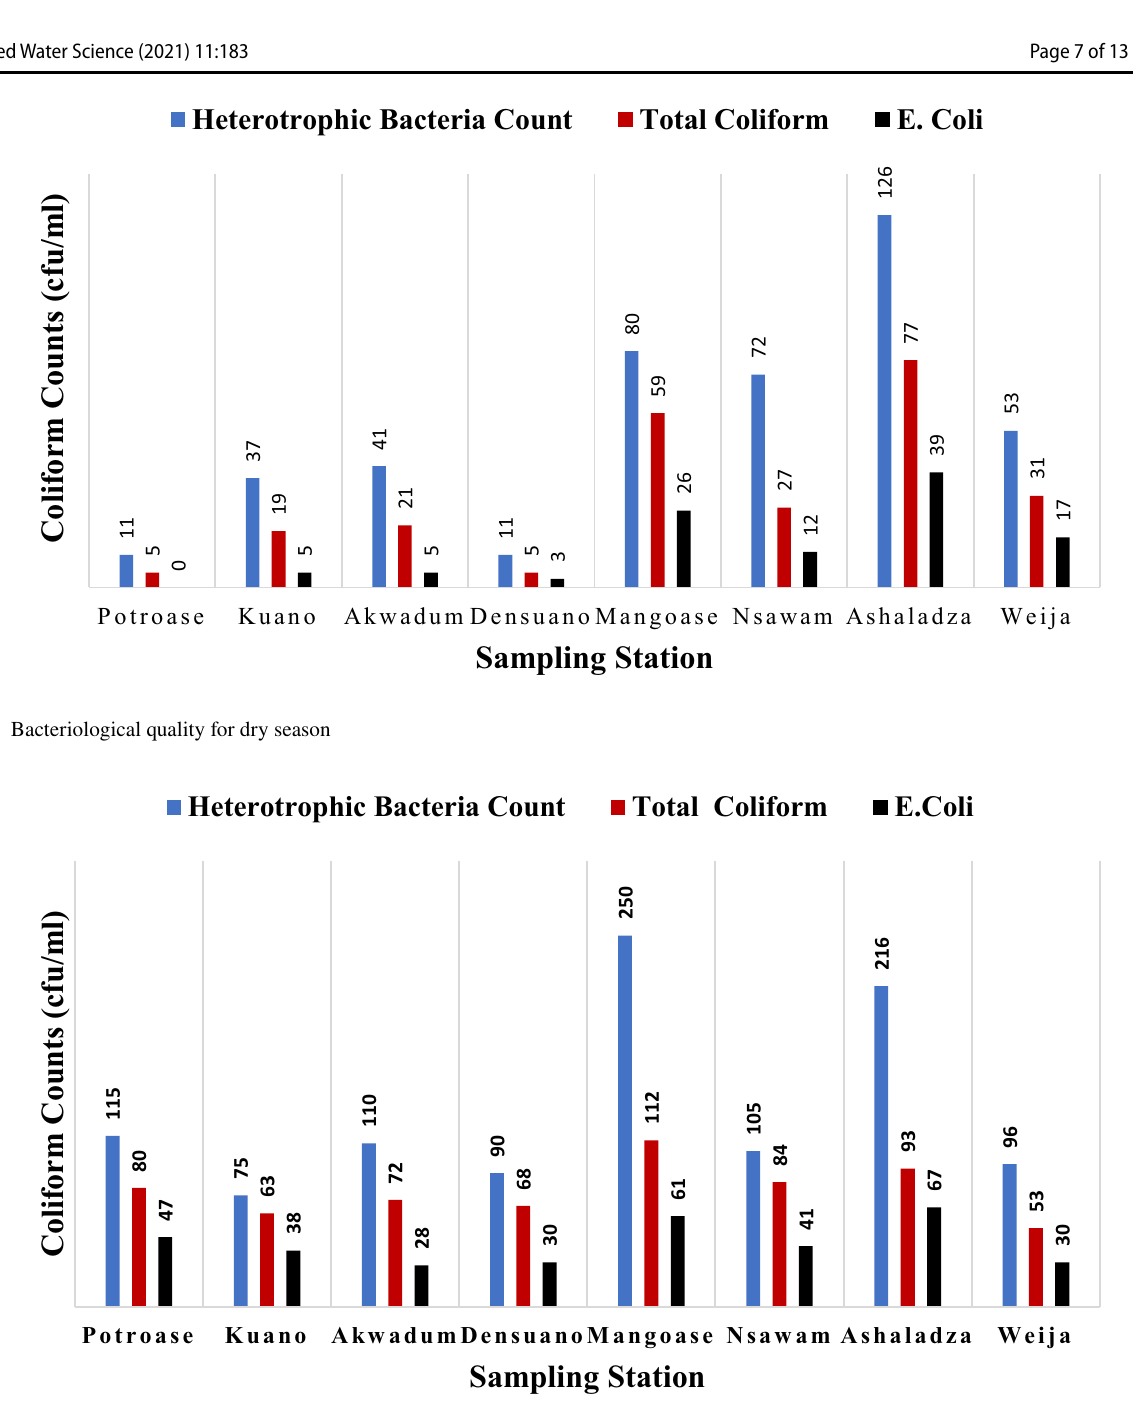
Fig. 7 Bacteriological quality for wet